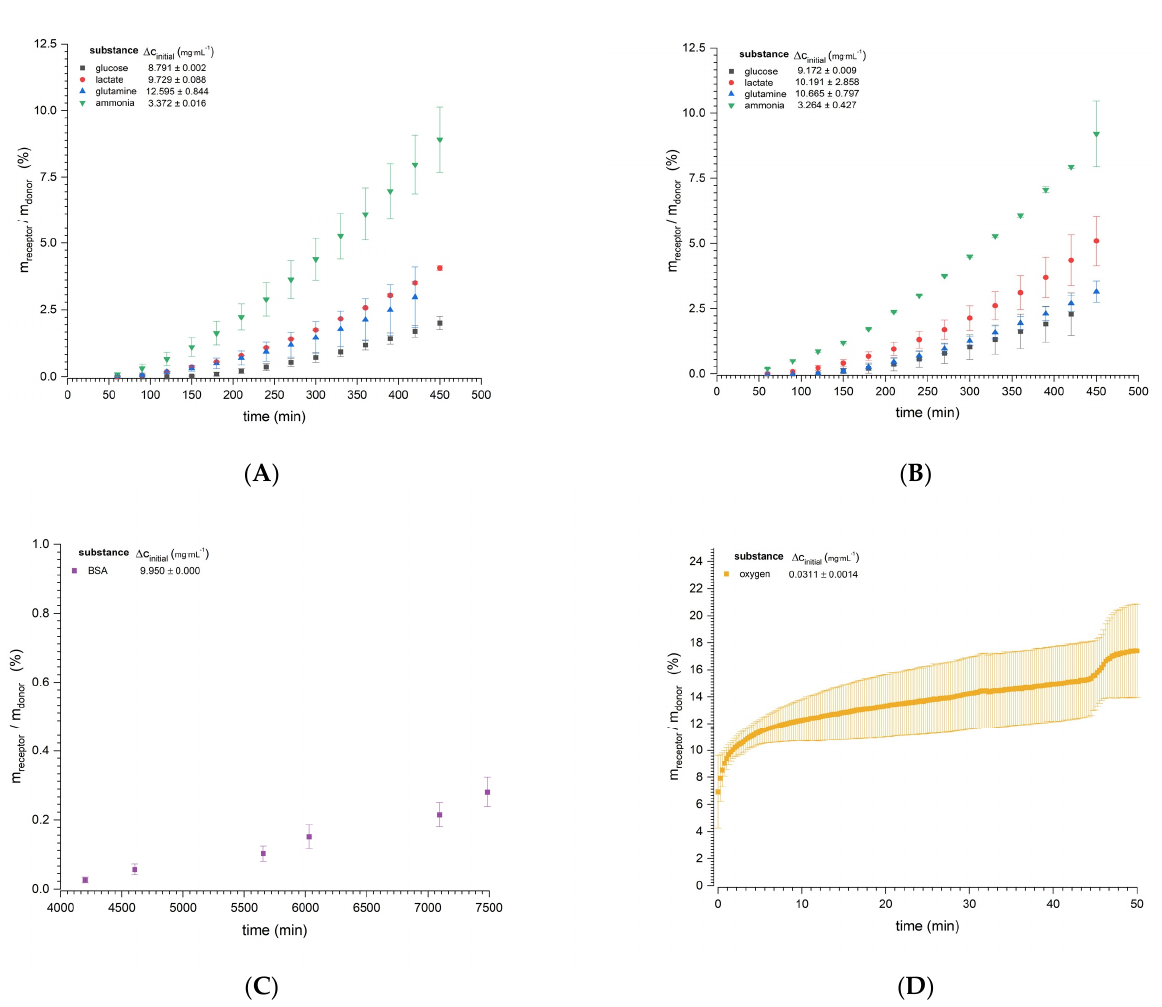
Figure 3. Mass transfer profiles for two different diffusion experiments as a quotient of the total mass in the receptor chamber and the initial mass in the donor chamber. The diffusion of glucose, glutamine, lactate, and ammonia through the nylon filter hydrogel sandwich is shown at ( A ) 37 ◦ C and ( B ) 32 ◦ C. ( C ) The diffusion of bovine serum albumin (BSA) is shown at 37 ◦ C. All experiments in panels ( A – C ) were based on the use of 10 Franz diffusion cells. ( D ) Oxygen diffusion at 25 ◦ C in an Ussing chamber. Initial concentration gradients are displayed in the upper left corner of each graph. Data are mean values ± SD ( n = 10 for panels ( A – C ), n = 4 for panel ( D